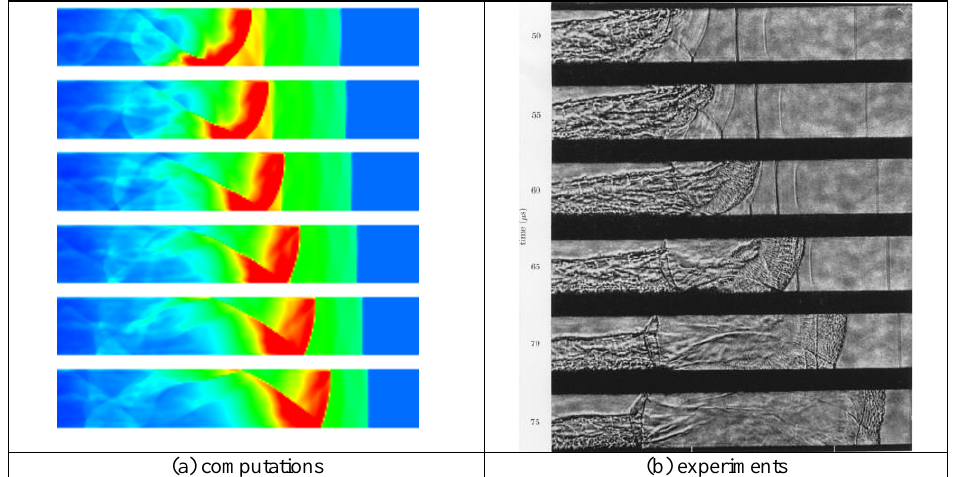
Figure 10 Comparison of numerical solutions and experiments